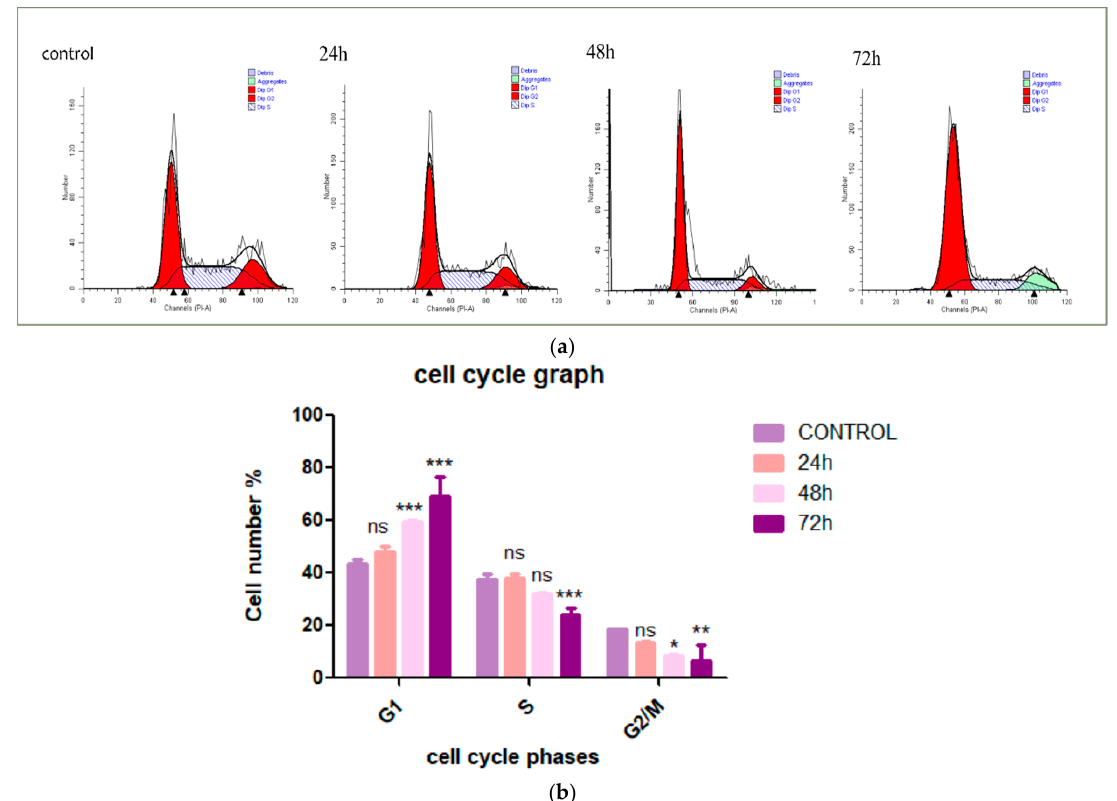
Figure 2. Inhibition of cell proliferation by CADMN via arresting cells at G1 phase. ( a ) Flow cytometry graphs of CADMN-treated HepG2 and untreated cells at different time points (24, 48 and 72 h). ( b ) Quantification analysis of the cell cycle assay. Data were presented as mean ± SD. * p < 0.05, ** p < 0.01, *** p < 0.001 indicate significant differences as compared to control.